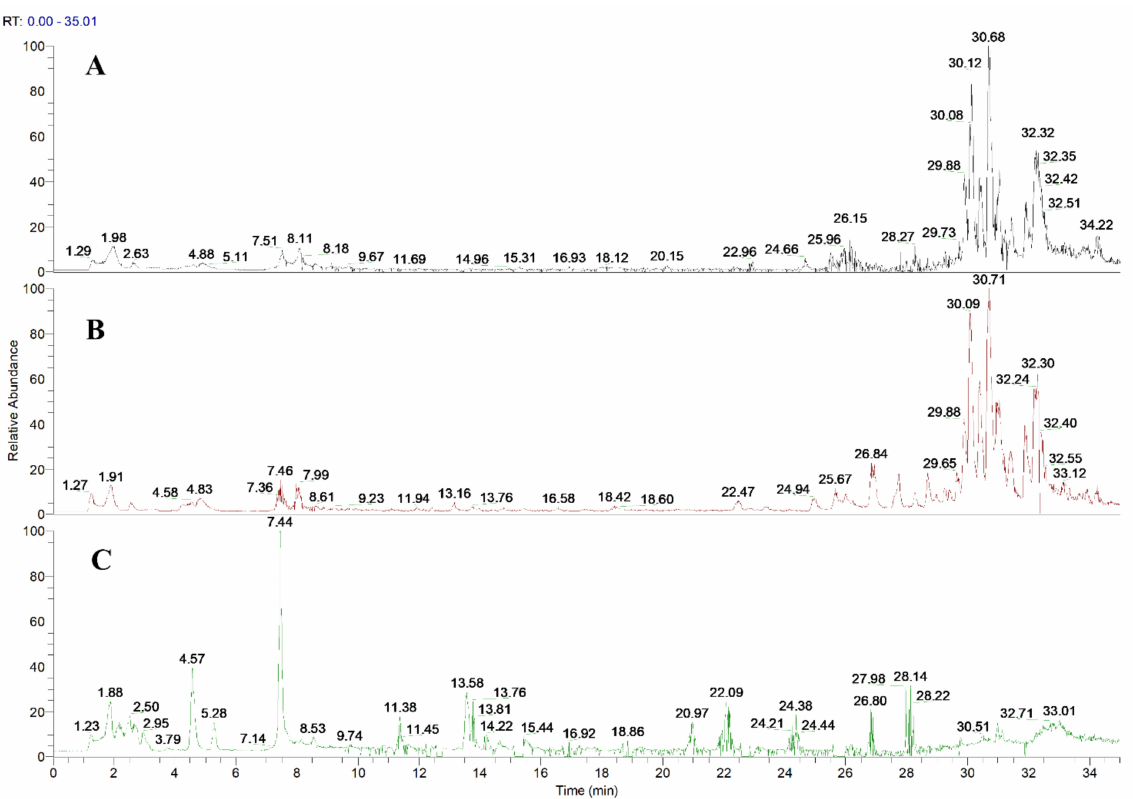
Figure 1. Identification of active components of toad venom in rat blood. ( A ) Blank blood. ( B ) Toad venom in rat blood. ( C ) Toad venom